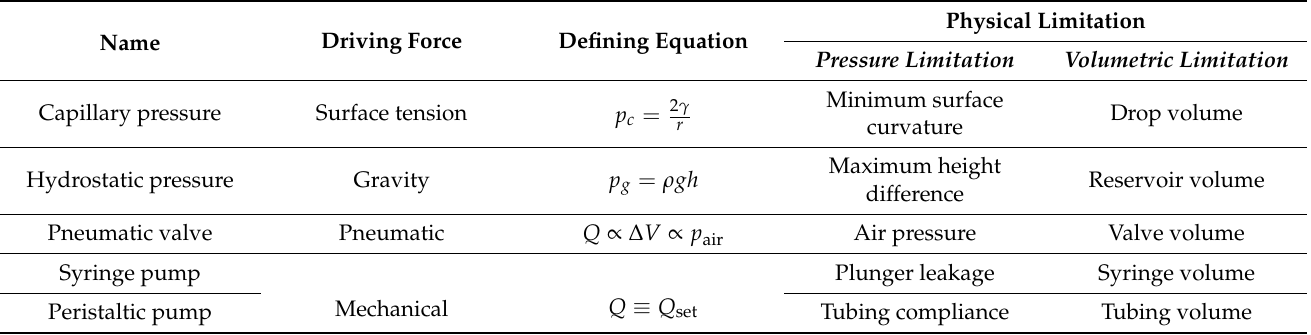
Table 1. List of common fluidic sources, driving forces, defining equations, and physical